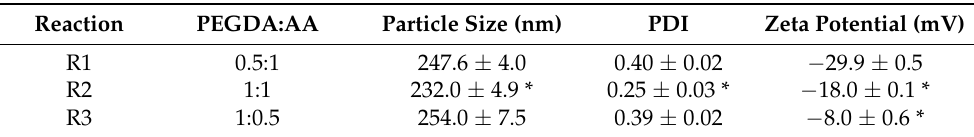
Table 1. Particle size, PDI, and zeta potential of the PEGDA/AA NPs. (* Significant difference from PEGDA:AA (0.5:1)), n = 3.